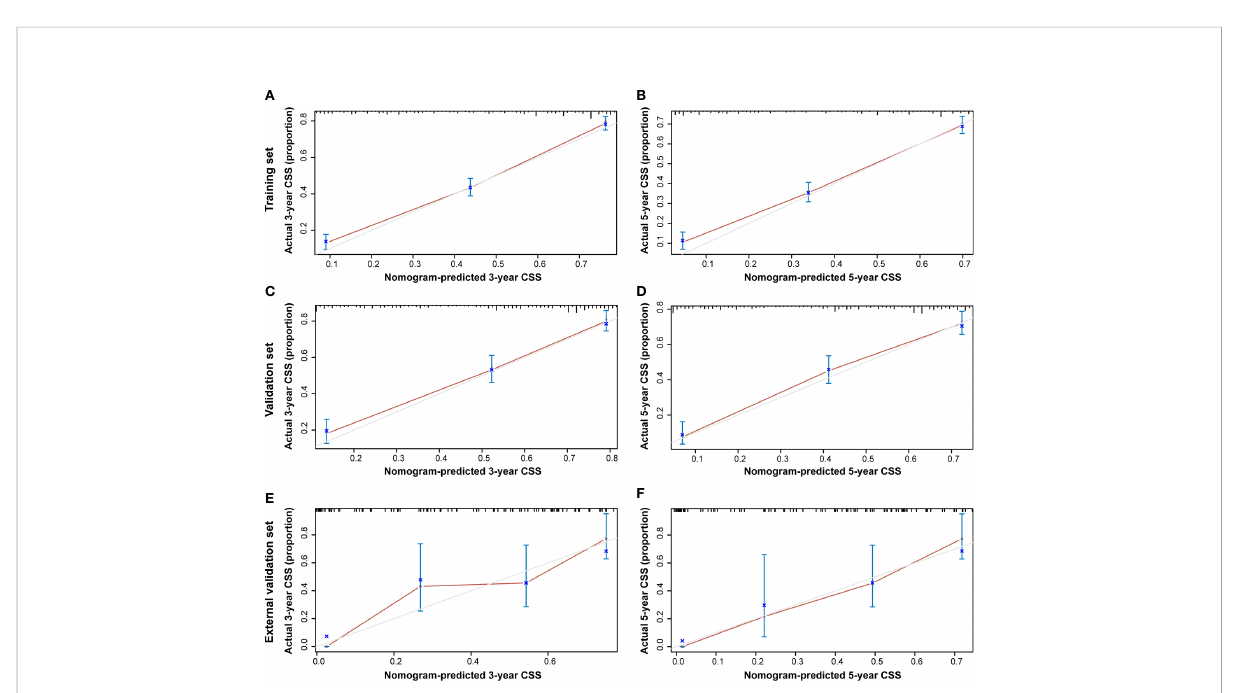
FIGURE 8 Calibration plot of the 3- and 5-year CSS nomogram. The calibration curves of the 3-year (A) and 5-year (B) nomogram model for CSS in the training set, respectively. The calibration curves of the 3-year (C) and 5-year (D) nomogram model for CSS in the validation set. The calibration curves of the 3-year (E) and 5-year (F) nomogram model for CSS in the external validation